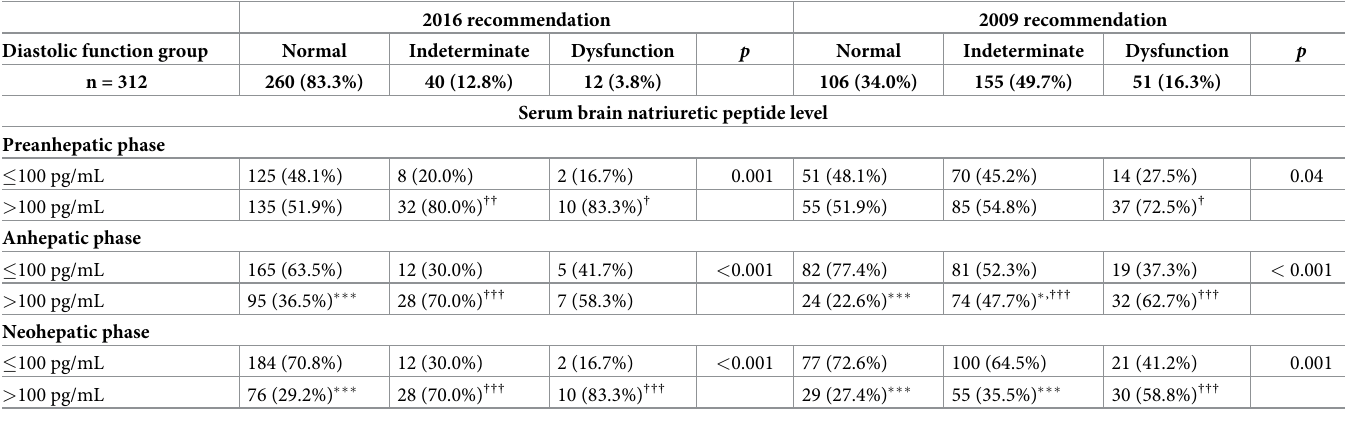
Table 4. Intraoperative change in the proportion of patients with a high serum brain natriuretic peptide level ( > 100 pg/mL) between the normal diastolic, indeter- minate, and diastolic dysfunction groups according to the 2016 and 2009 recommendations during living-donor liver